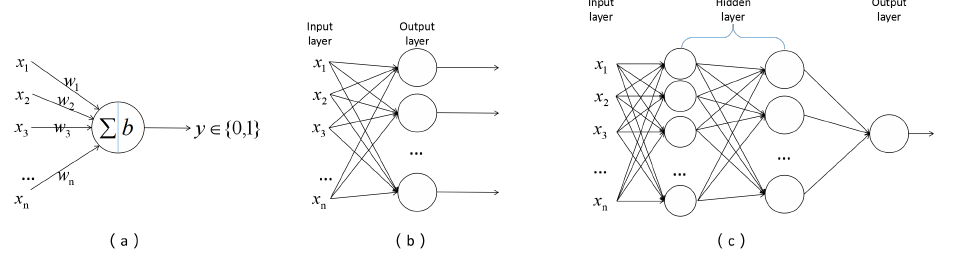
Figure 1. ( a ) A McCulloch-Pitts Neuron model with its inputs, weights, bias and output; ( b ) A perceptron and its input layer and output layer; ( c ) A multi-layer perceptron that has input layer, hidden layers and output